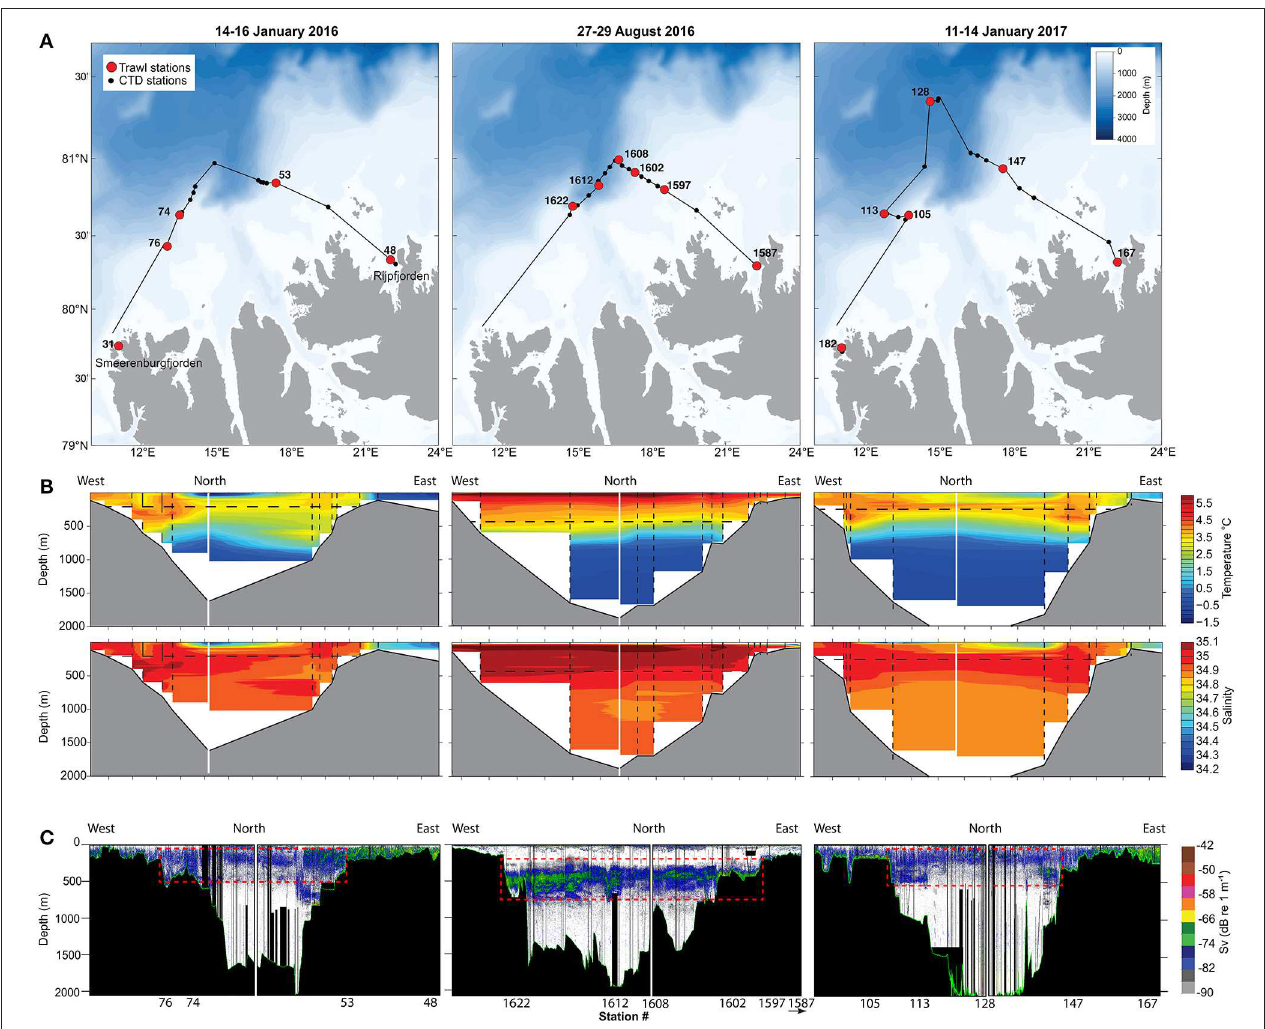
FIGURE 1 | (A) Ship’s track (solid lines) and stations where the midwater trawl (red dots) and CTD (black dots) were deployed. (B) Temperature and salinity profiles along the ship’s track. The vertical dashed lines indicate the location of the CTD profiles and the horizontal dashed lines indicate the WMD. (C) Echograms of volume backscattering strength (Sv) at 38kHz. The dashed rectangles indicate SSL used in biomass calculations. Locations of the stations are indicated under the echograms.